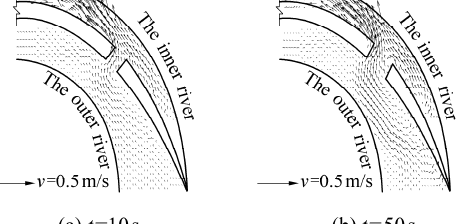
Fig. 7 Typical flow field near the breach.